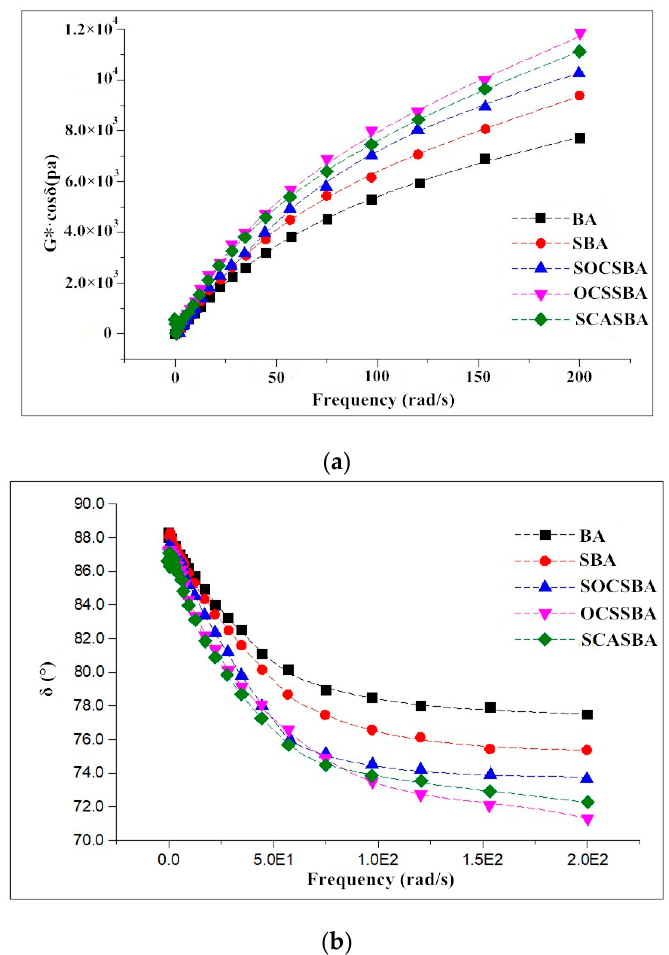
Figure 15. The changes of storage modulus and phase angle of five asphalt binder with frequency at 58 °C. ( a ) storage modulus ( b ) phase angle.